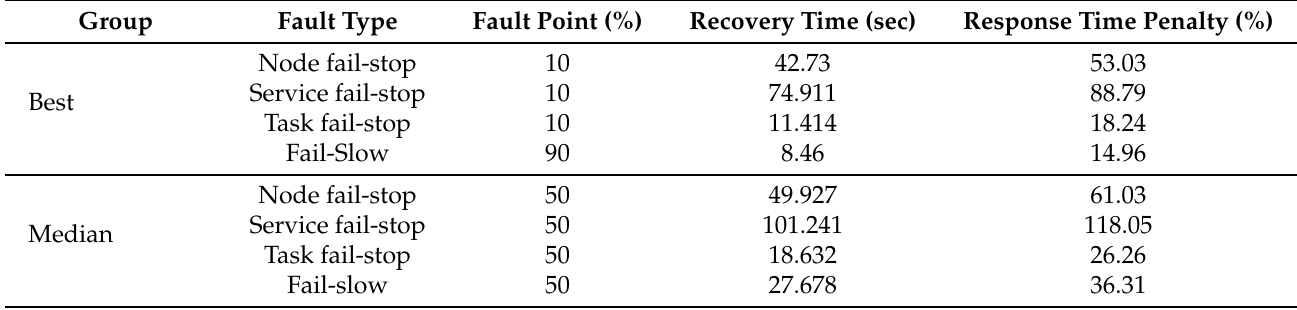
Table 4. Comparison between the best, median and extreme values in terms of fault recovery time, fault point and response time penalty when setting optimal fault-tolerance